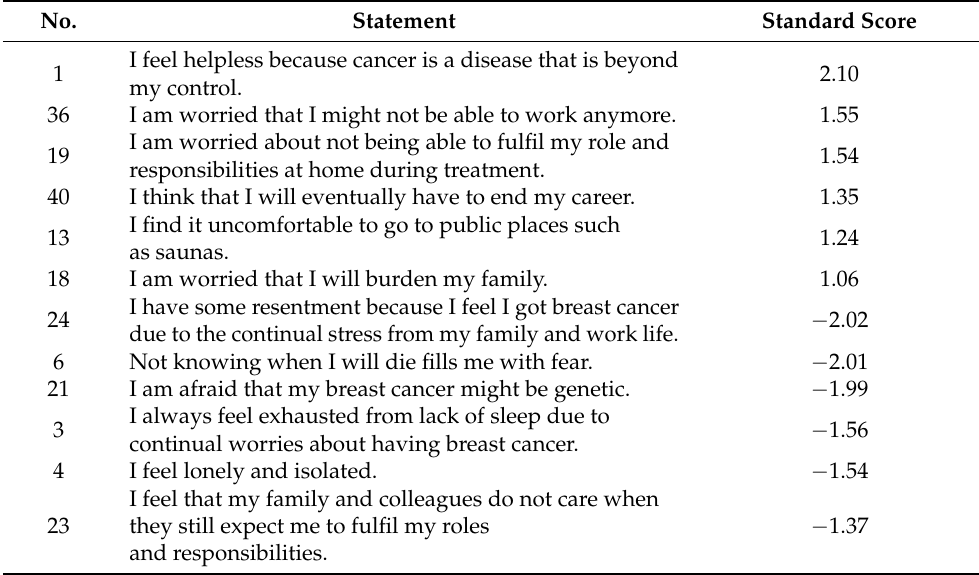
Table 8. Representative statements and standard scores (at least ± 1.00) of Type 3.